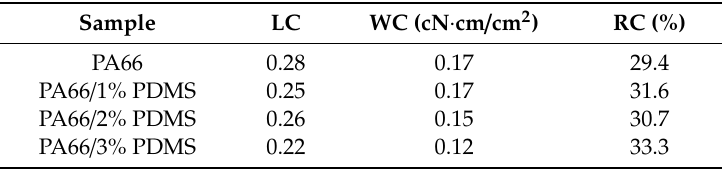
Table 4. Compression properties of the